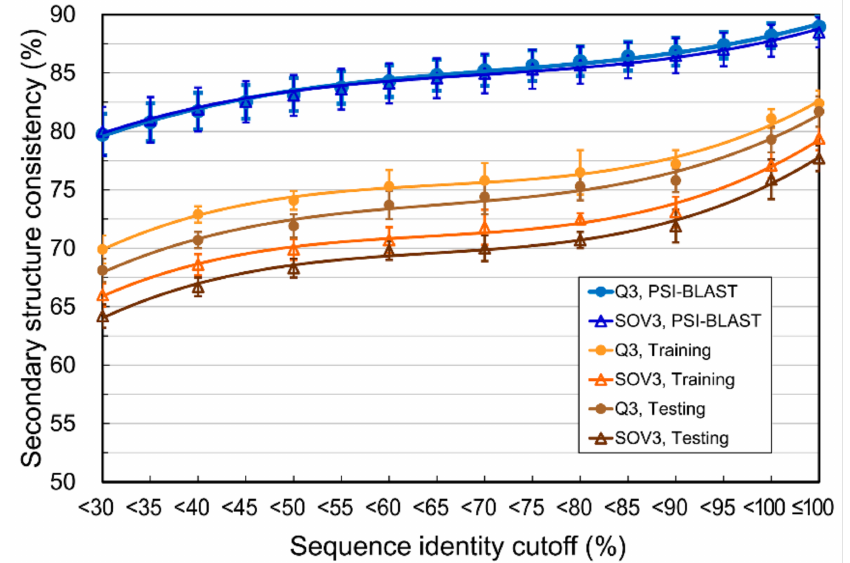
Figure 7. The accuracy of the current SSP methodology applied with restricted homology